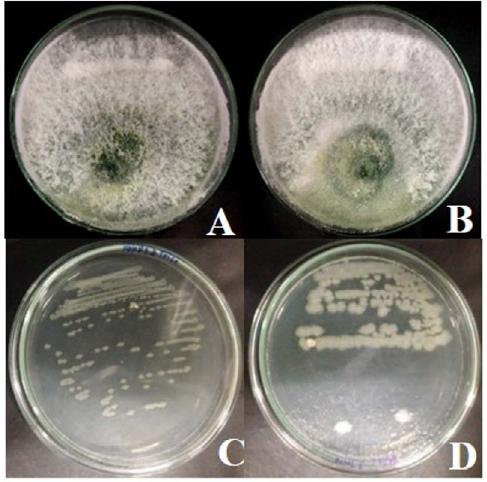
Fig. 4. Compatibility test of antagonistic bacteria B. pumilus FDKF5 or Bacillus sp. IKM1 and Beauveria bio-product A: Beauveria bio-products and Bacillus pumilus FDKF5 B: Beauveria bio-products and Bacillus sp. IKM1 C: Re -streak of Bacillus pumilus FDKF5 D: Re -streak of Bacillus sp.